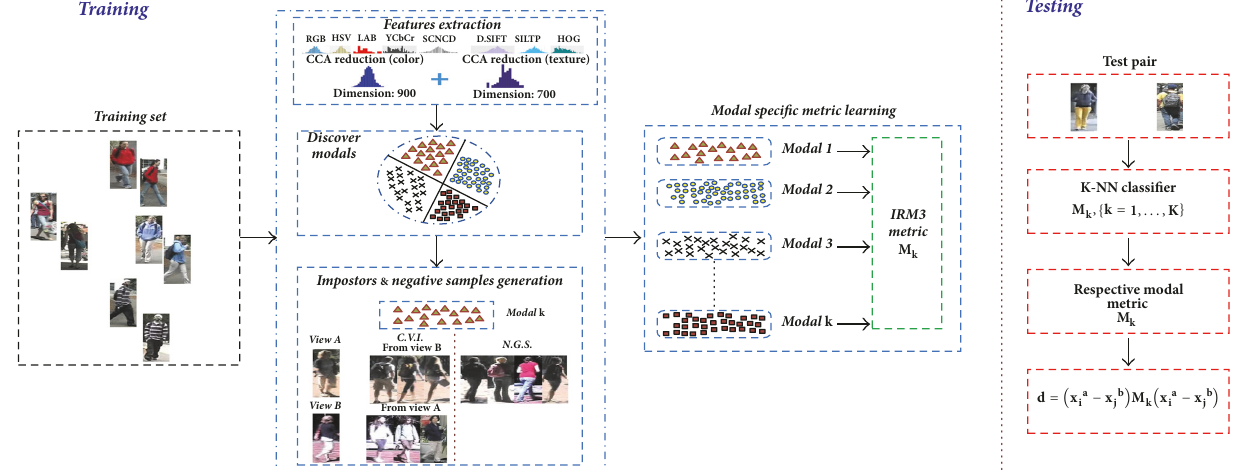
Figure 2: Impostor resilient multimodal metric learning (IRM3) for person reidentification.